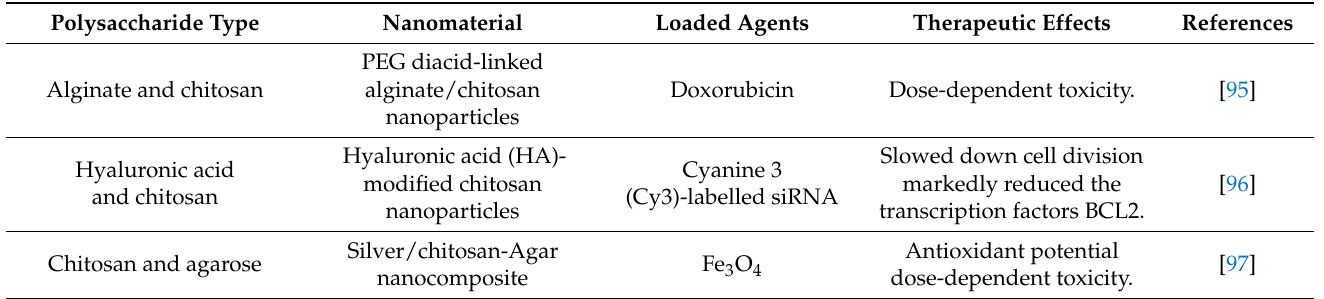
Table 3. Combination of polysaccharide-based nanoparticles as lung cancer treatment delivery systems. Polysaccharide